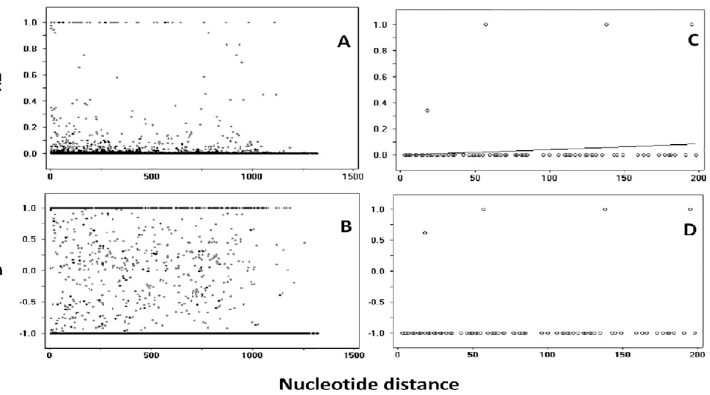
Fig 4. Linkage disequilibrium plots of R2 and D’ for Pvama1 and Pvmsp1 19 kDa region for global isolates. (A) Linkage disequilibrium plots of R2 and (B) D’ for Pvama1 ectodomain, (C) linkage disequilibrium plots of R2 and (D) D’ for Pvmsp1 kDa region were calculated by Fisher’s exact 19